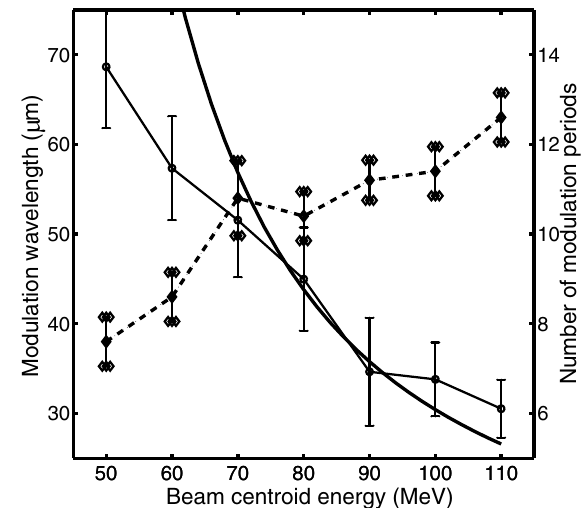
FIG. 4. Measured dependencies of the average modulation wavelength (solid) and the average number of modulation periods (dashed) versus beam centroid energy. The solid curve represents the result of analytic calculation (see text for